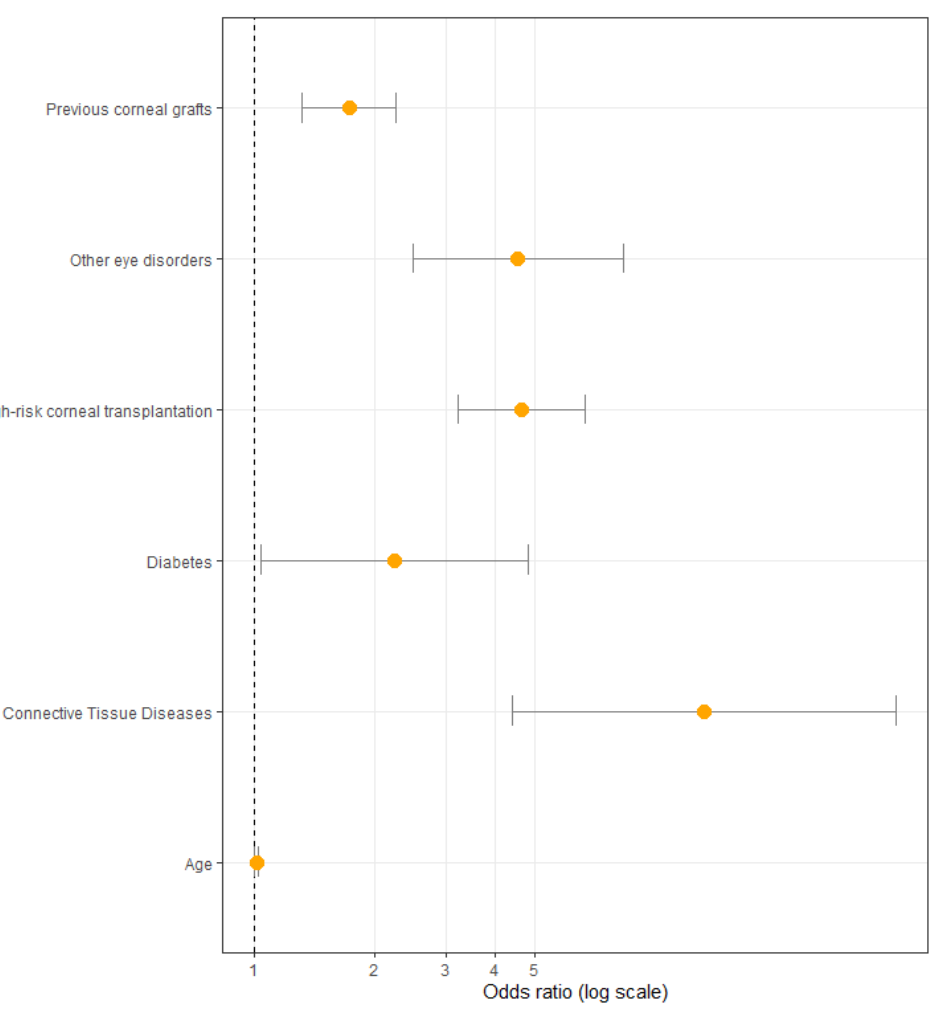
Figure 3. Odds ratio with confidence intervals of the studied factors included in univariate analy ‐ sis.